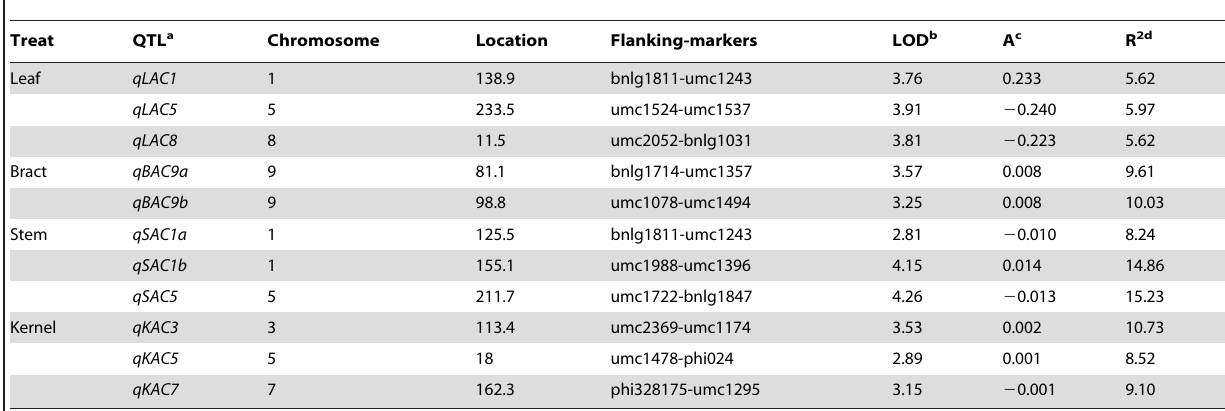
Table 3. QTLs detected for arsenic concentration in the four tissues in maize.